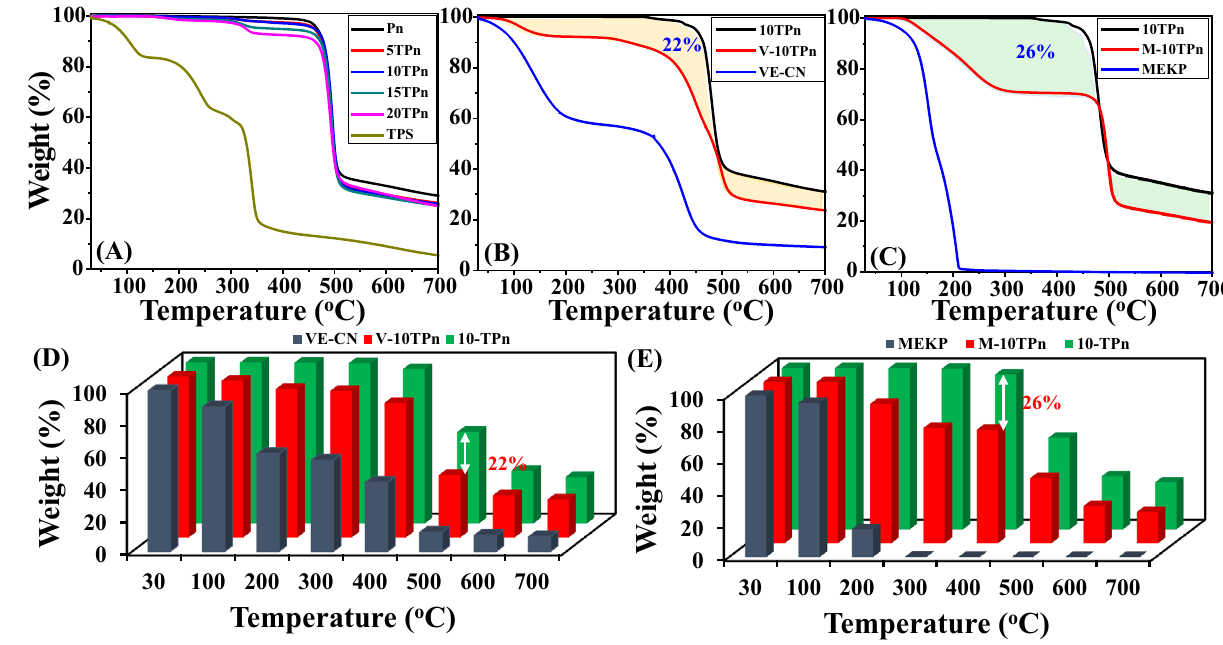
Figure 6. TGA curves of ( A ) TPS/PVDF, ( B ) V–10TPn, ( C ) M–10TPn and ( D , E ) Schematic description about volume % of healing agent (VE–CN and MEKP) in TPS/PVDF nano fibers in the light of thermal